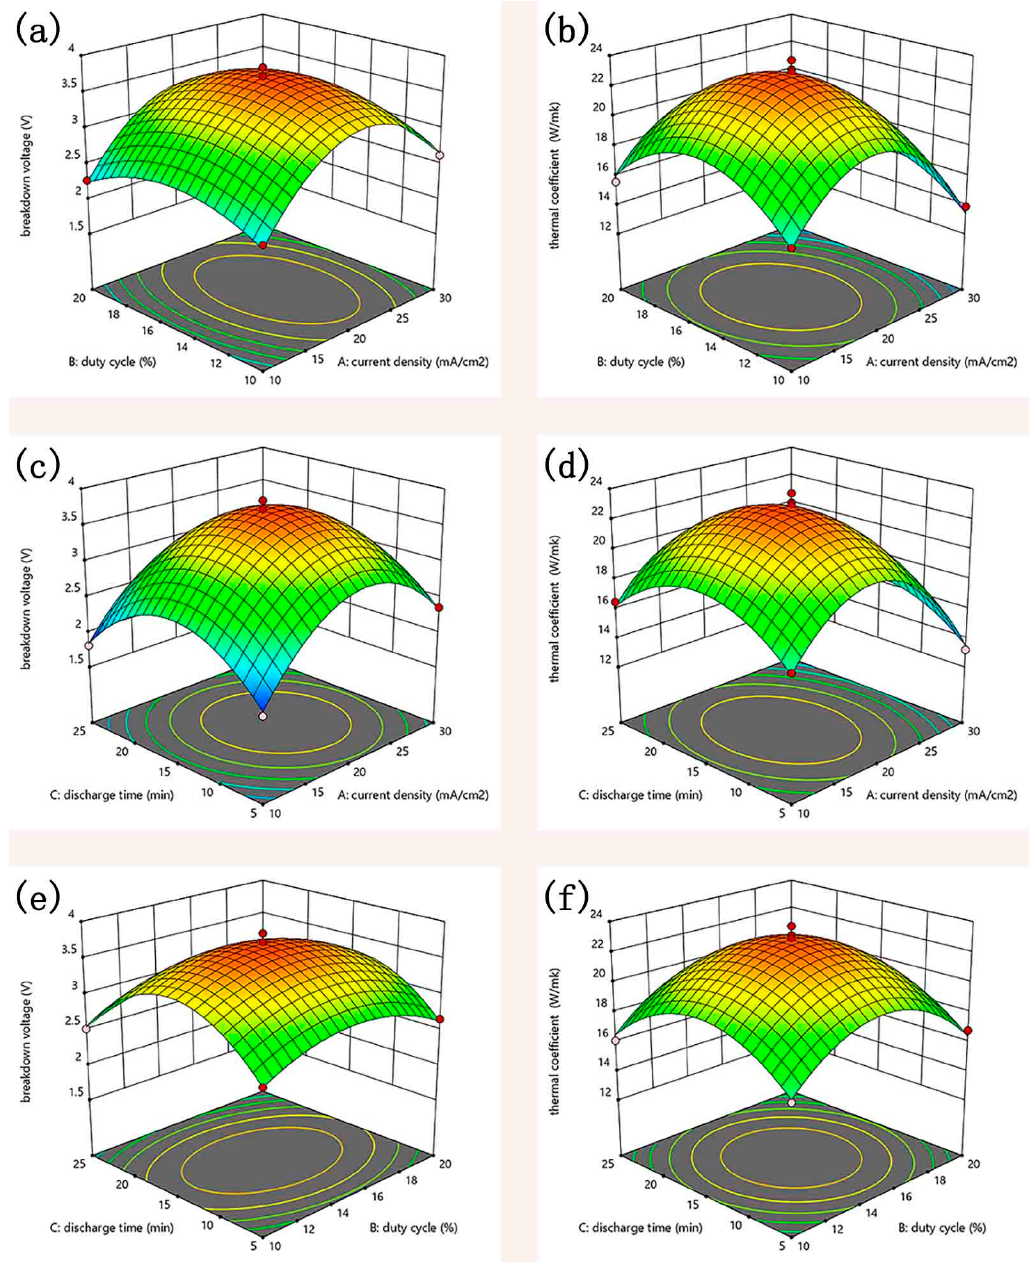
Figure 9. The interaction effect of current density, duty cycle and discharge time on the breakdown voltage ( a , c , e ) and thermal conductivity ( b , d , f ) of the APD coating.